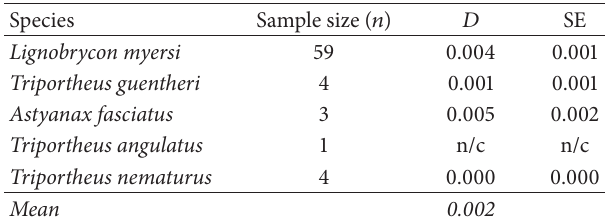
Table 3: Intraspecific genetic distance ( 𝐷 ) and standard error (SE) of COI sequences based on K2P model.